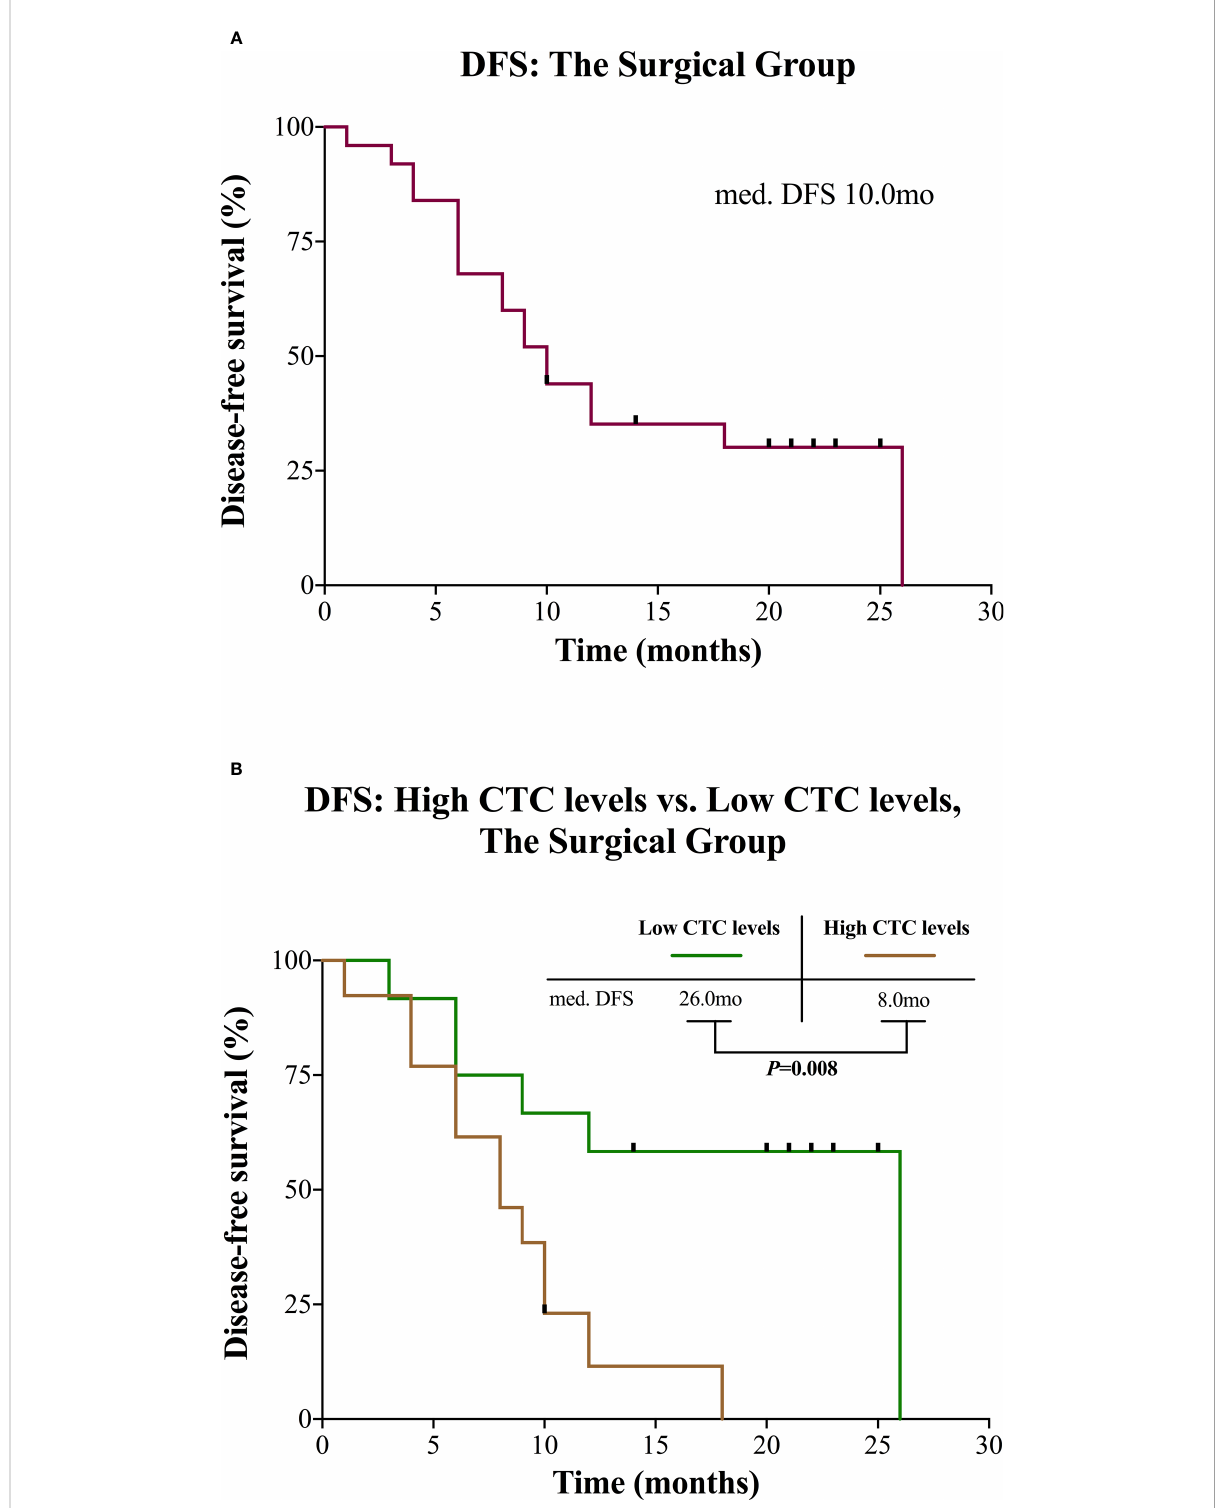
FIGURE 3 Kaplan-Meier curves for patients in the surgical group. (A) DFS for the entire group. (B) DFS of the surgical group divided into high and low CTC levels. CTC, circulating tumor cell; DFS, disease-free survival; mo, months; med.,